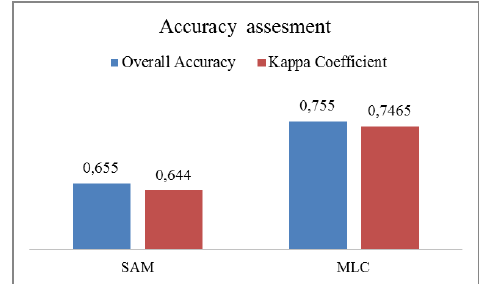
Figure 12: Compared accuracy of SAM and MLC